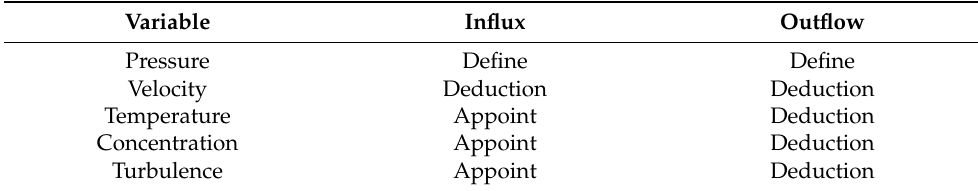
Table 3. Exit boundary